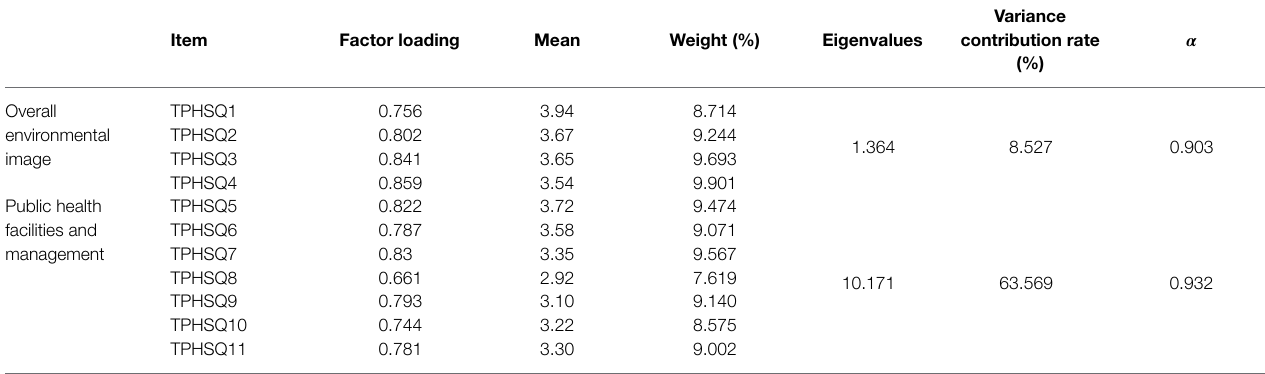
TABLE 2 | Exploratory factor analysis (EFA) and reliability test.